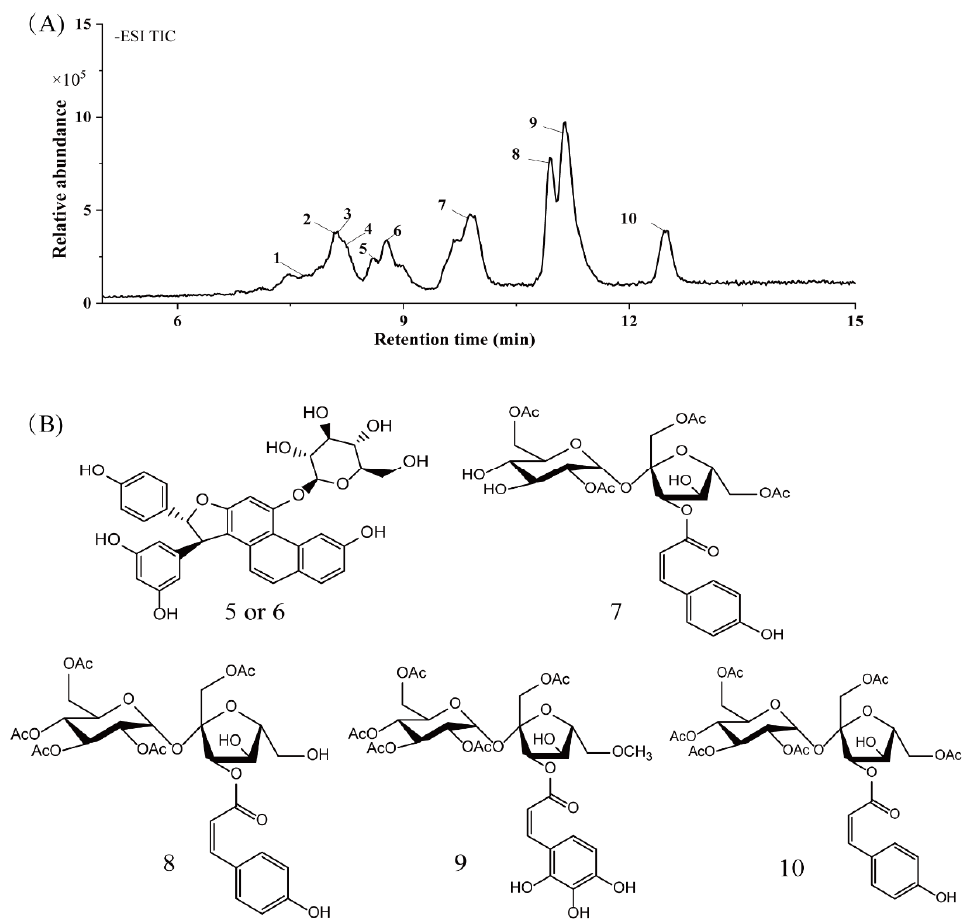
Figure 5. ( A ) The HPLC-MS/MS total ion current (TIC) chromatogram. The numbers 1–10 above the peaks indicate the location of the identified compounds. ( B ) Chemical structures of the 5–10 compounds. 5 or 6: vaterioside A; 7: 1,6,2’,6’-tetraacetyl-3- O -p-coumaroylsucrose; 8: 1,2 ′ ,3 ′ ,4 ′ ,6 ′ -pentaacetyl-3- O -p-coumaroylsucrose; 9: 6-methoxy-1,2 ′ ,3 ′ ,4 ′ ,6 ′ -pentaacetyl-3- O -p-3,4,5-trihydroxy cin- namoyl sucrose; and 10: 1,6,2 ′ ,3 ′ ,4 ′ ,6 ′ -hexaacetyl-3- O -p-coumaroylsucrose.